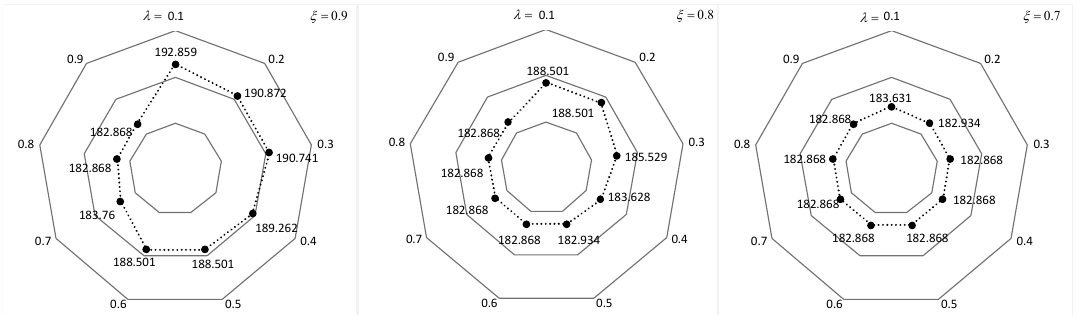
Figure 11. Total system cost under different λ values and ξ levels.